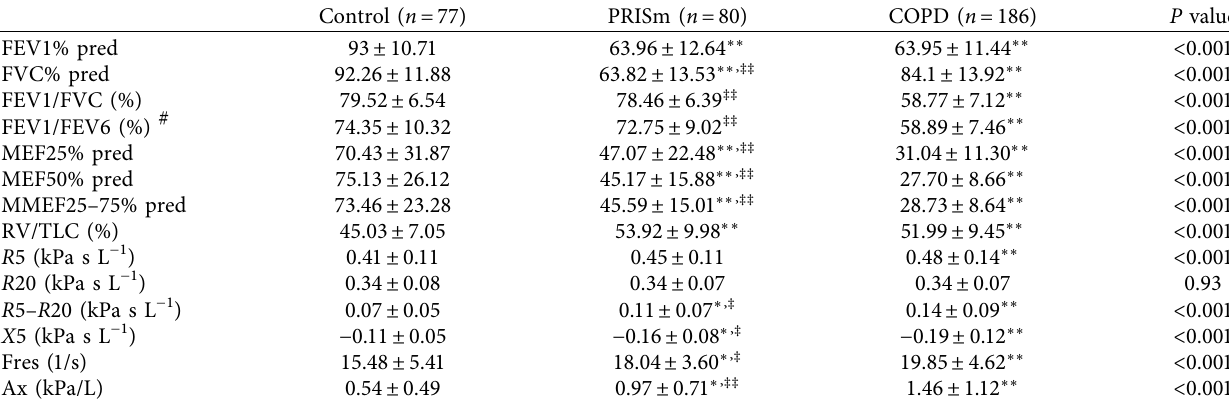
Table 2: Analysis of variances results for three groups in this study (mean ±